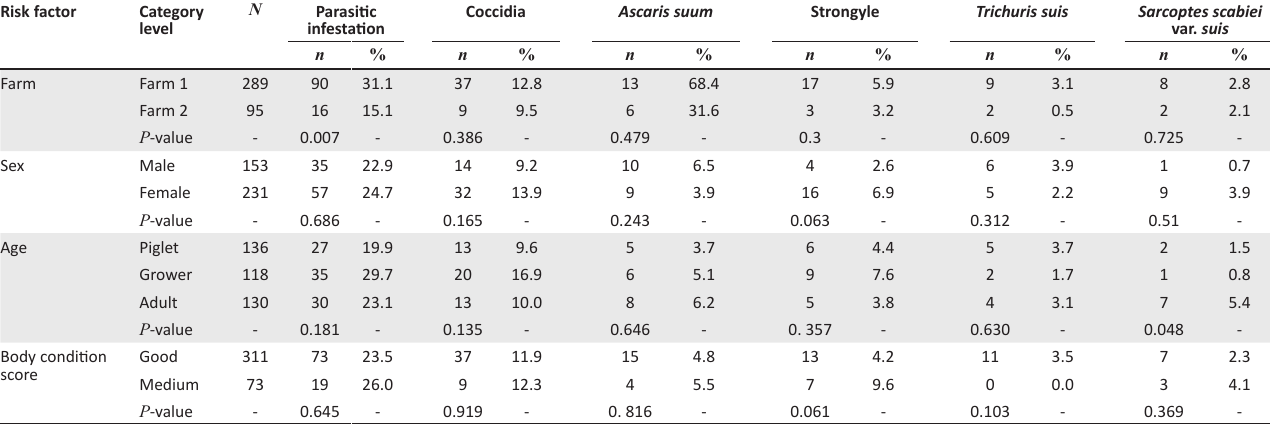
TABLE 2: Distribution of parasites according to farm, sex, age and body condition score of pigs in Bishoftu. Risk factor Category N Parasitic level infestation